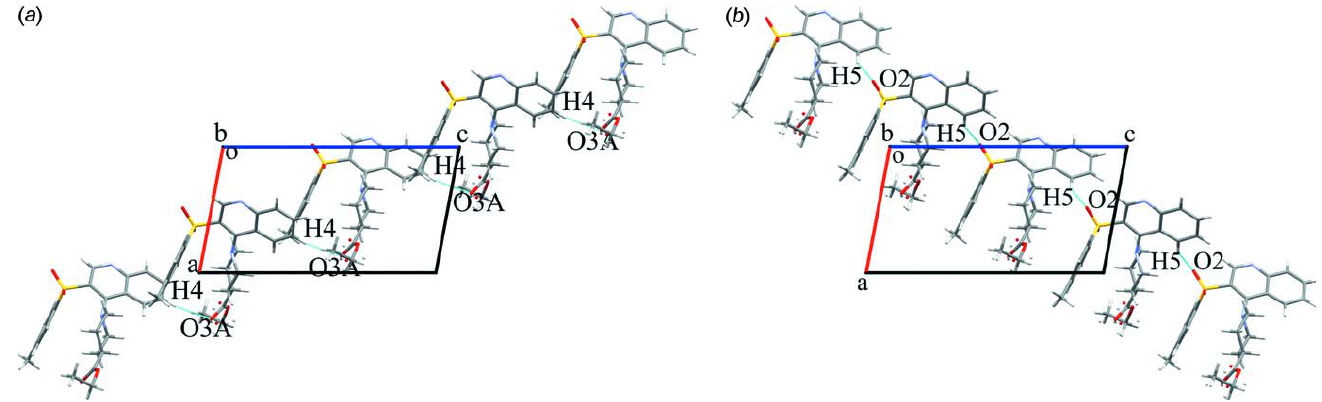
Figure 2 Crystal packing of the chains built with the hydrogen bonds C4—H4 (cid:2)(cid:2)(cid:2) O3 A ( a ) and C5—H5 (cid:2)(cid:2)(cid:2) O2 ( b ) in cyan. Projection in the [010]